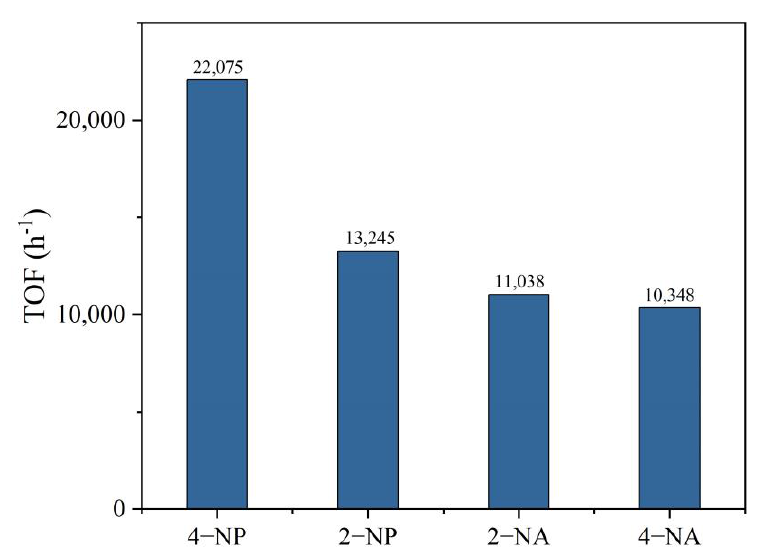
Figure 7. Reactivity of other nitroaromatic by single-atom catalysts.